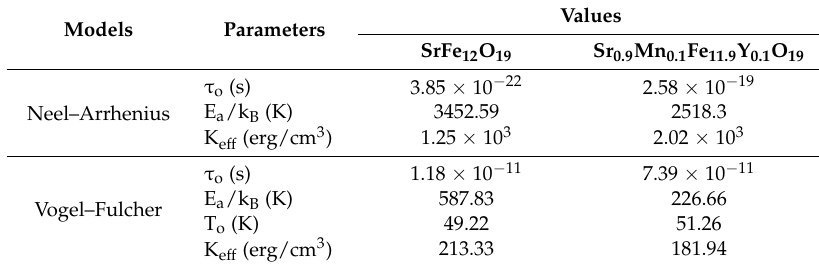
Figure 11. ln(f) against 1/T B for the two selected SrFe 12 O 19 (i.e., x = y = 0.0) and Sr 0.9 Mn 0.1 Fe 11.9 Y 0.1 O 19 (i.e., x = y = 0.1) where solid line presents Neel–Arrhenius (N-A) model fit. Table 3. Physical parameters of the selected Sr 1 − x Mn x Fe 12 − y Y y O 19 (x = y = 0.0 and 0.1) nanohexaferrites obtained from Neel–Arrhenius and Vogel–Fulcher model fitting.